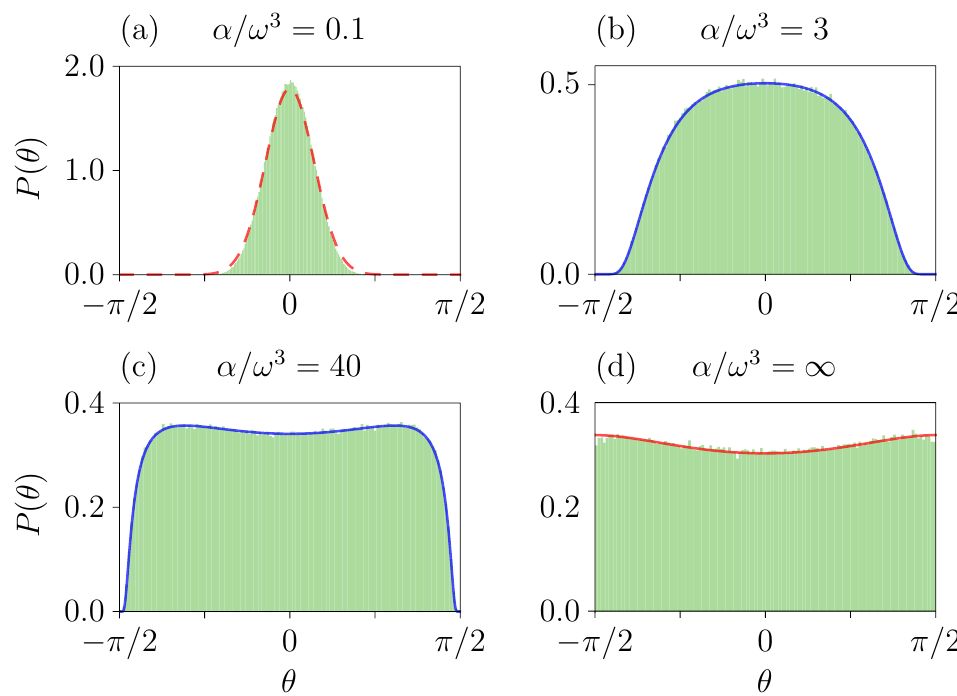
Figure 5: Probability distribution function of the NFT angle, P ( θ ) , for several values of α/ω 3 : (a) 0.1, (b) 3, (c) 40, (d) ∞ . Green histograms are obtained by direct Monte-Carlo simulation of Eq. (1). The dashed red line in panel (a) is the approxi- mate solution (3). Numerical solutions of Eqs. (9) and (11) are shown by blue lines. The solid red line in panel (d) is the analytical solution (17) for ω =